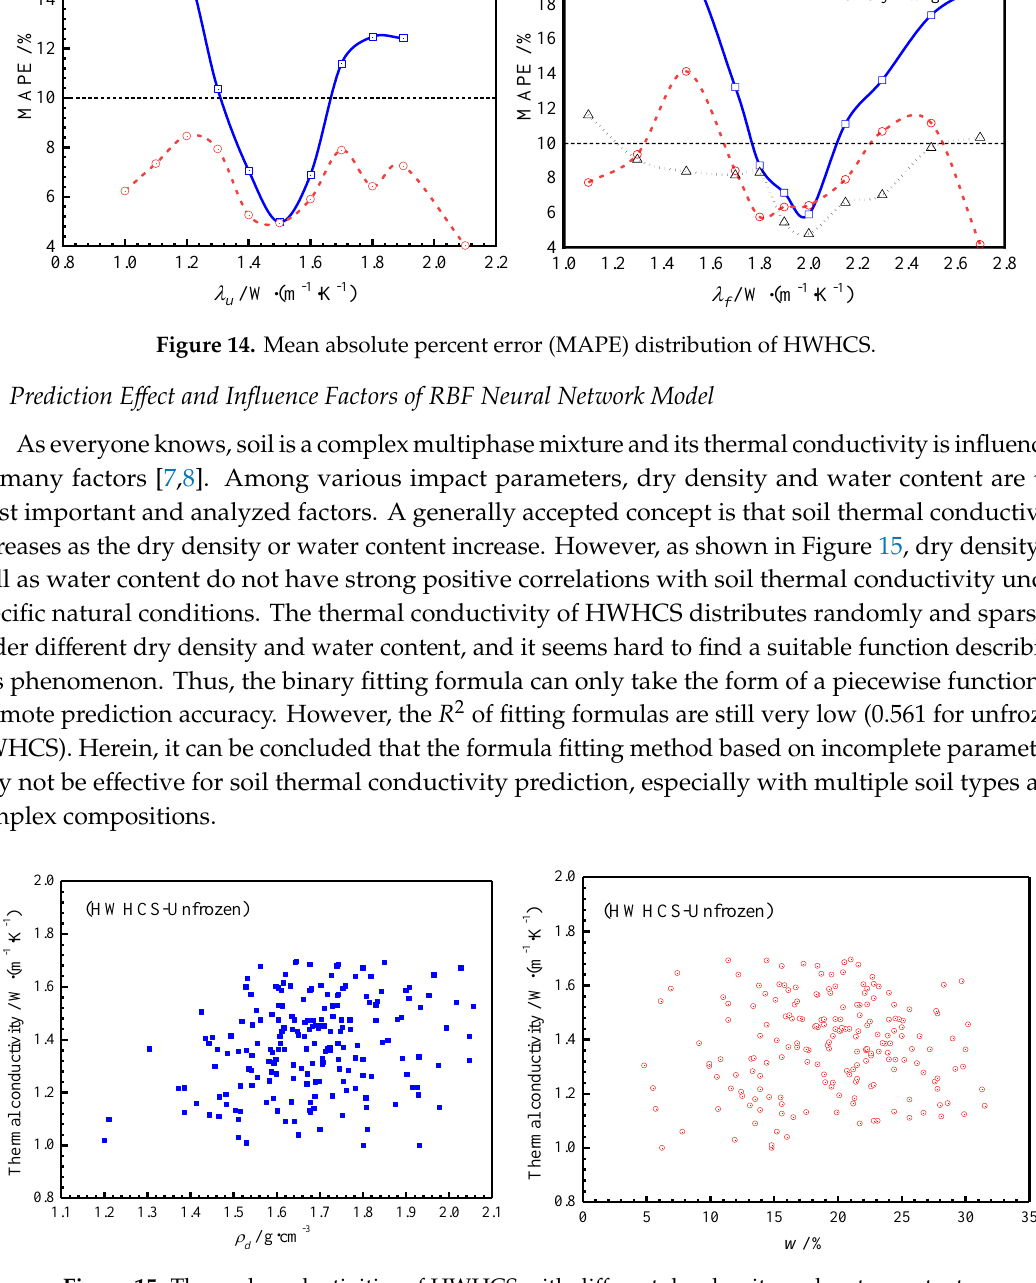
Figure 15. Thermal conductivities of HWHCS with different dry density and water content.